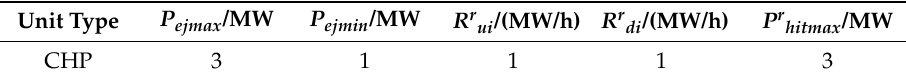
Table 3. Combined heat and power unit parameters.